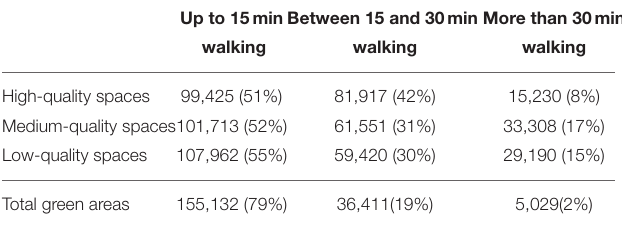
TABLE 3 | Population with access to urban green spaces in Chillán, considering a total of 184,800 inhabitants. Up to 15min Between 15 and 30min More than 30min walking walking